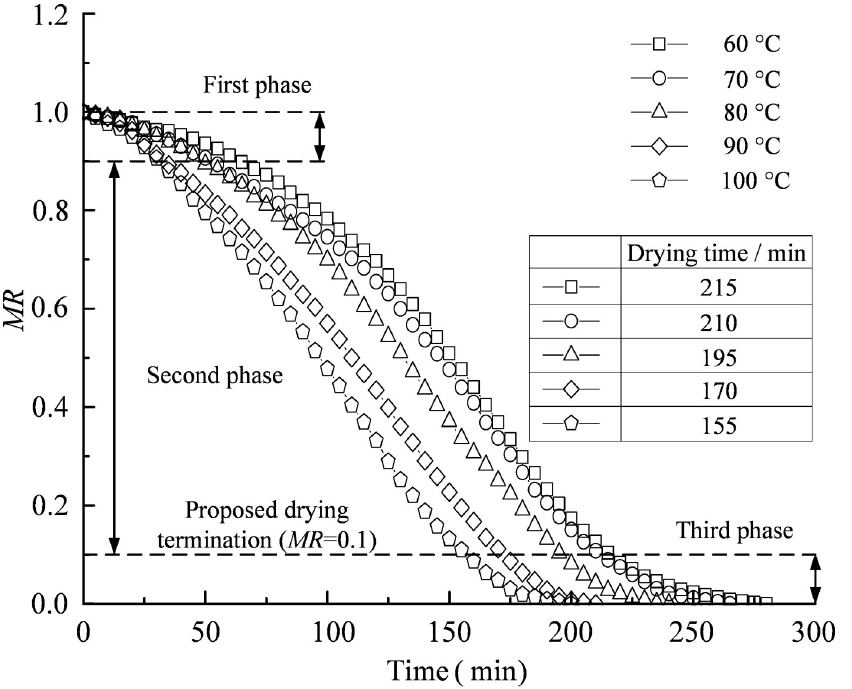
Fig 4. Variations in moisture ratio with time under different